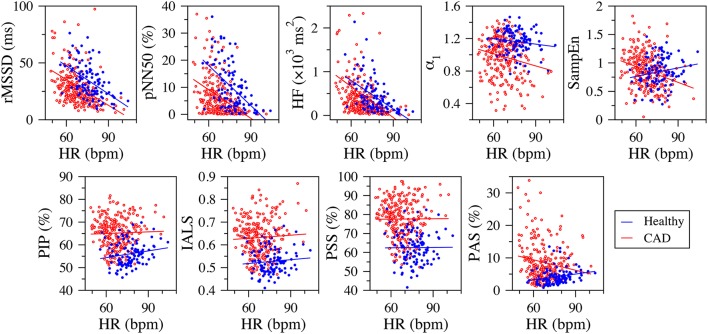
Scatter plots of the traditional heart rate variability (rMSSD, pNN50, and HF), nonlinear (α1 and SampEn) and fragmentation (PIP, IALS, PPS, and PAS) indices vs. mean heart rate (in beats per minute, bpm) for the group of healthy subjects (blue dots) and those with coronary artery disease (CAD, red circles), derived from the analysis of 24-h NN interval time series. The blue and red lines are the linear regression lines for the healthy and CAD groups, respectively. rMSSD, root mean square of the successive differences; pNN50, percentage of differences between successive NN intervals above 50 ms; HF, high frequency spectral power; α1, detrended fluctuation analysis short-term exponent; SampEn, sample entropy; PIP, percentage of inflection points; IALS, inverse of the average length of the acceleration/deceleration segments; PPS, percentage of NN intervals in short segments; PAS, percentage of NN intervals in alternation segments.